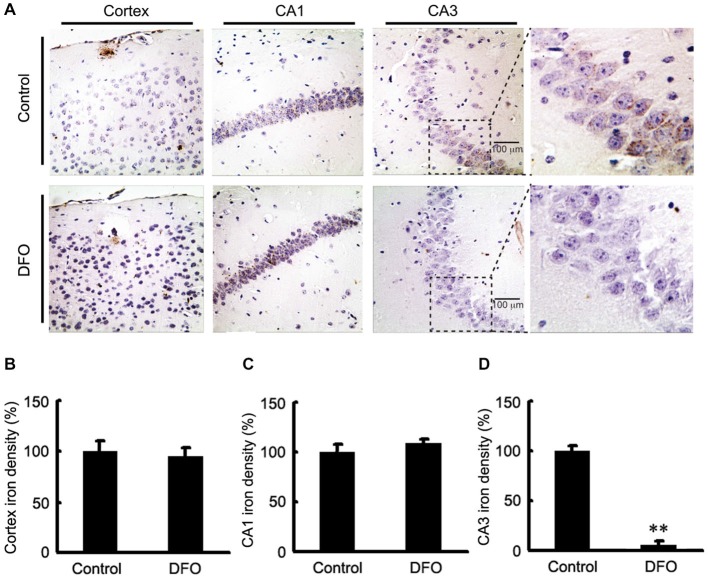
Fe accumulation in the cortex and hippocampus of APP/PS1 mice. (A) APP/PS1 transgenic mice were treated with control or DFO (200 mg/kg) for 3 months before sacrifice. The right hemisphere of the brains were quickly dissected, fixed in 4% paraformaldehyde in phosphate buffered saline at 4°C overnight, embedded in paraffin, cut into sections (5 μm) and stained with modified Perl’s-DAB to reveal the distribution patterns of Fe ions in the cortex and hippocampus. Fe deposits can be observed as brown granules. In the cortex and hippocampus, there are many Fe-positive cells, most of which are neurons with cytoplasmic Fe deposits, especially CA1 area of hippocampus. Importantly, Fe ions were only detected in the CA3 area of the hippocampus untreated mice. (B–D) Bar graphs illustrating the semi-quantitative Fe ions densitometry measurements as percentages of the intact side. Scale bar = 100 μm. These images are representative of 6 independent experiments, all revealing similar results. **P < 0.01 vs. control group.